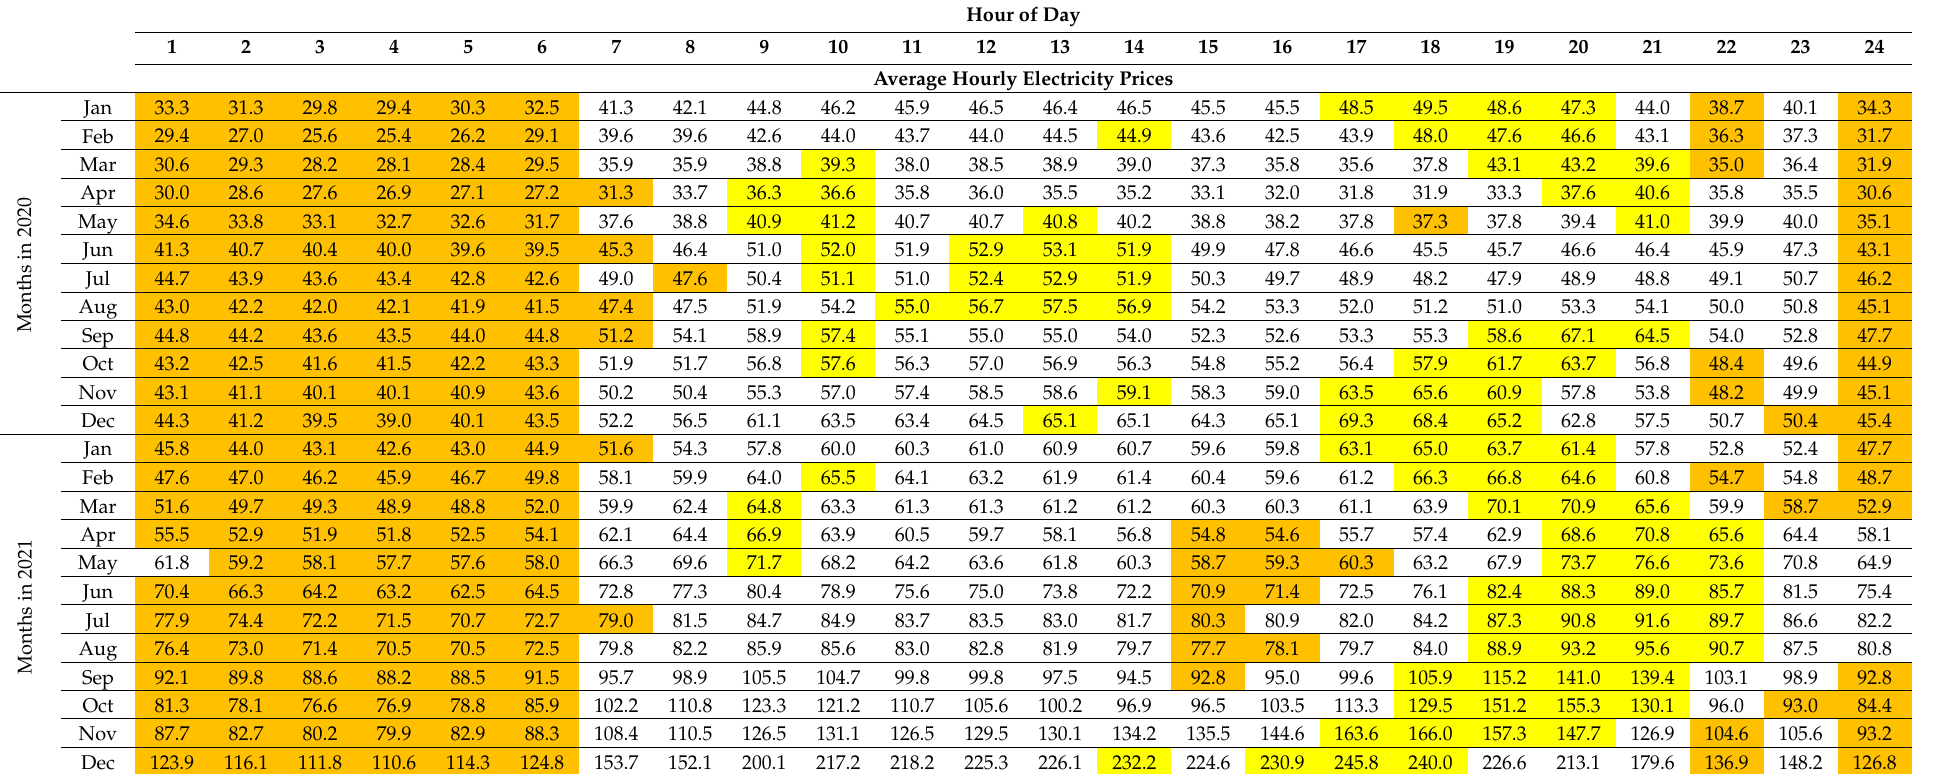
Table 1. Average monthly electricity prices for specific hours of day in Poland in years 2020 and